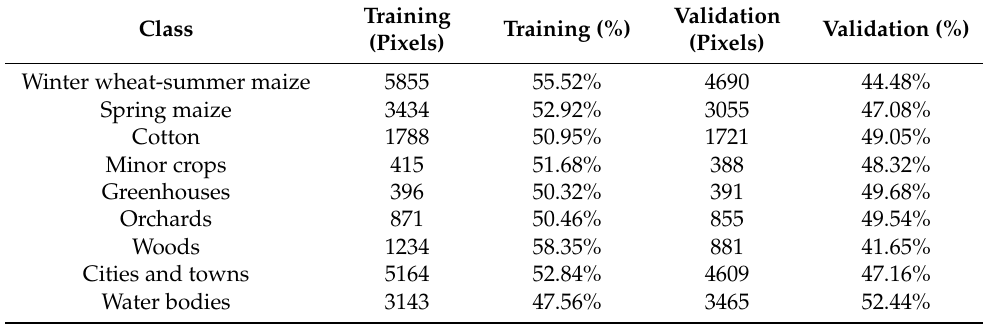
Table 3. Number of samples in different